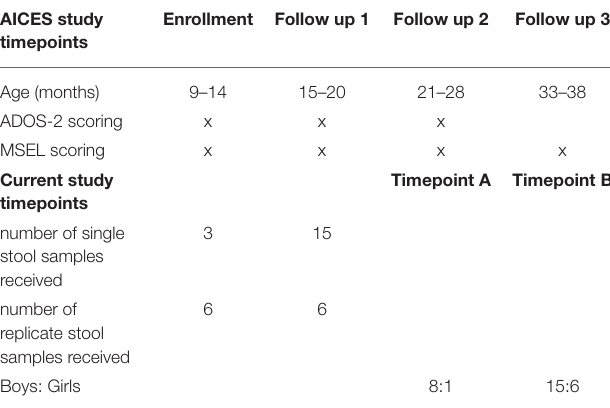
TABLE 1 | Enrolment, follow-up time points, and behavioral testing that took place in the AICES RCT. AICES study